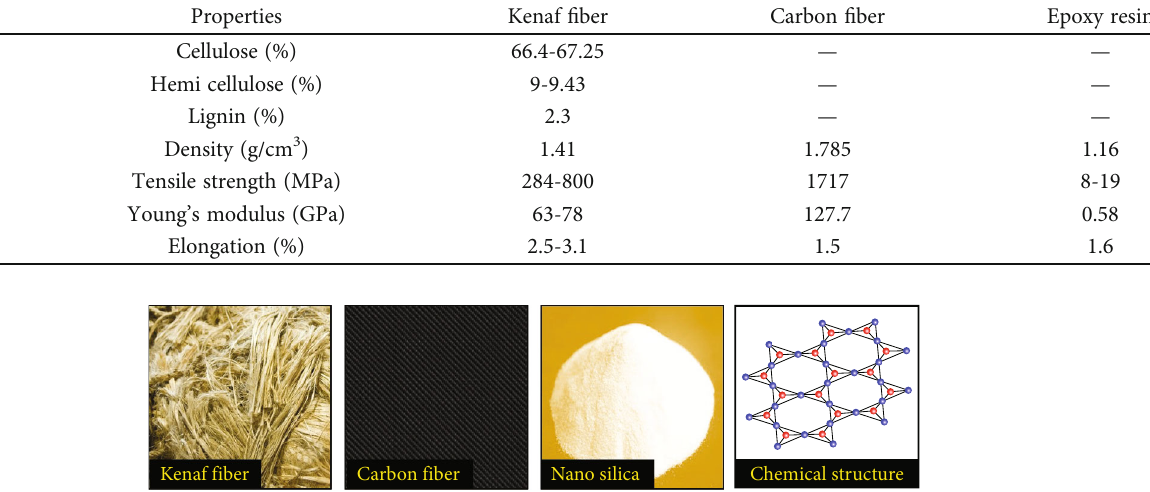
Figure 1: Photographic image of reinforcement and nanosilica and its chemical structure. Table 2: Parameters and their levels for nanocomposite.